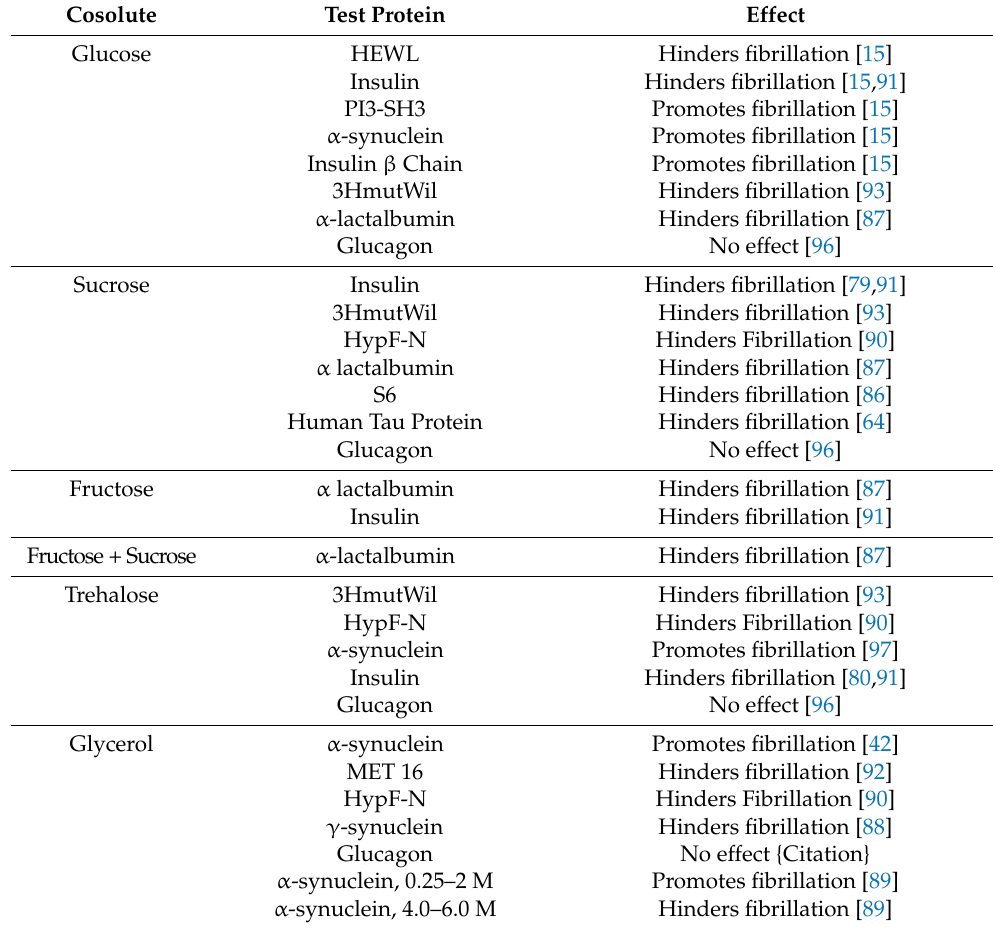
Table 2. Effects of osmolytes and small molecules on protein